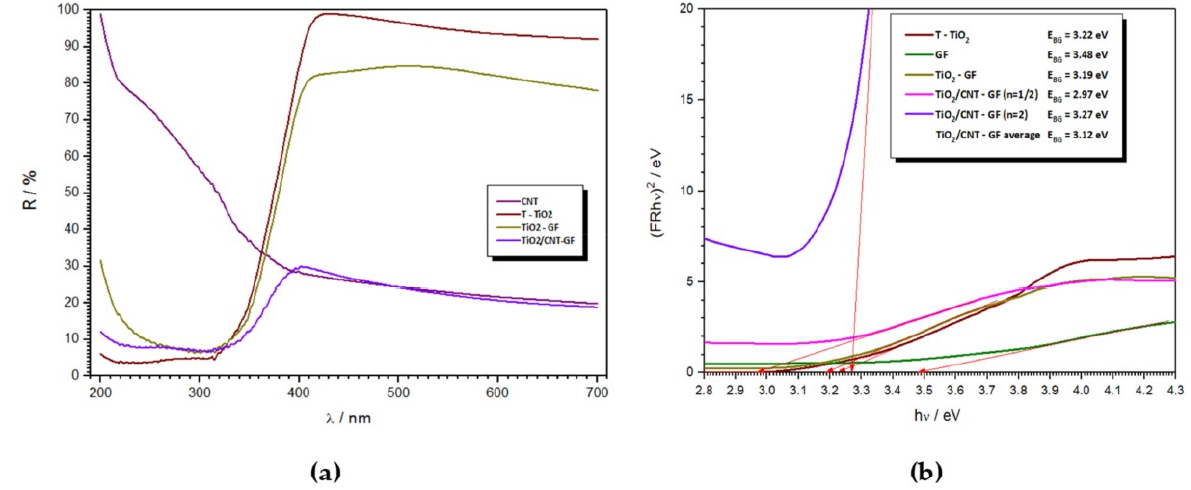
Figure 2. ( a ) DRS UV-vis spectra; ( b ) Tauc plot for the photocatalytic film constituents and photocat- alytic composites on glass mesh